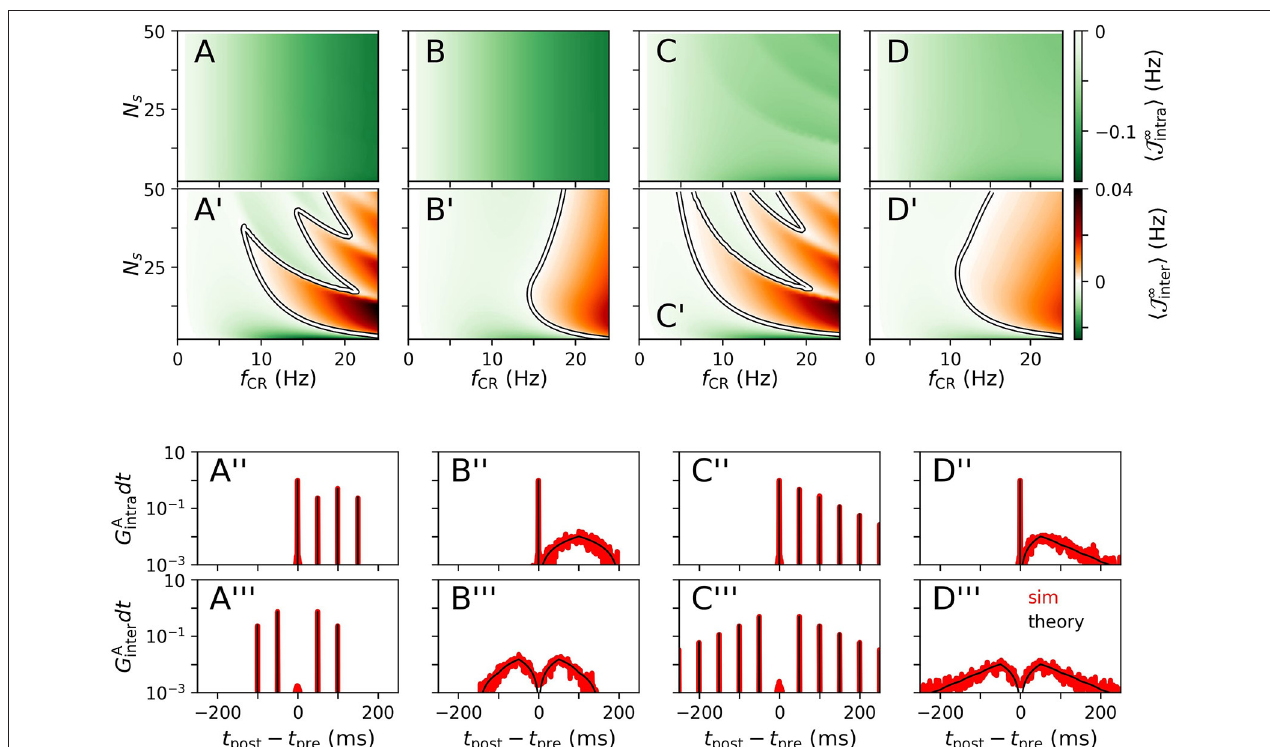
FIGURE 2 | Theoretical estimates of stimulation-induced weight dynamics and distributions of time lags for different CR stimulation patterns. Individual columns correspond to CR (A) , NCR (B) , SCR (C) , and SNCR (D) stimulation patterns. Panels show the estimated mean rates of weight change h J ∞ X i , Equation (4), for intrapopulation (A–D) and interpopulation synapses (A’–D’) , respectively. Here, X = “intra,” “inter” marks the considered type of synapses. White curves mark zero contour lines and indicate the boundary between strengthening ( h J ∞ X i > 0) and weakening of synapses ( h J ∞ X i < 0). Corresponding estimates for the distributions of time lags that lead to weight updates G A X ( t ) (black), Equation (5), are compared to simulation results (red) in (A”–D”) for intrapopulation synapses and in (A”’–D”’) for interpopulation synaspes, respectively. In (A”–D”,A”’–D”’) , we set N s = 2 and f CR = 10 Hz. Networks were simulated for 90 s of ongoing stimulation. Time lags have been recorded from 400 pairs of pre- and postsynaptic neurons. Pairs were sorted according to synapse types “intra” and “inter” and histograms were calculated using a bin size of 1 ms. Theoretical estimates for J ∞ X were obtained by numerical calculations of p A X ( s ), Equation (17). To this end, the time interval [ − 1,000,1,000] ms was discretized using a binsize of dt = 0.01 ms. Then, G X ( t ) was obtained using Equation (5). To compare theoretical estimates and simulation results, we plotted G X ( t ) dt in (A”–D”,A”’–D”’) and normalized the histograms such that counts summed up to two. Parameters: t d = 3 ms, η = 0.02, τ + = 10 ms, τ R = 4, β =